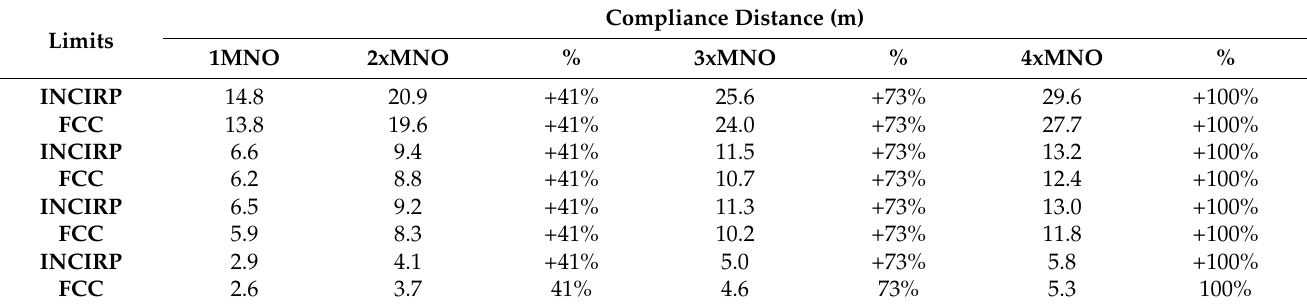
Table 3. The R CD for macro site shared by up to 4 MNOs, referencing the ICNIRP and FCC